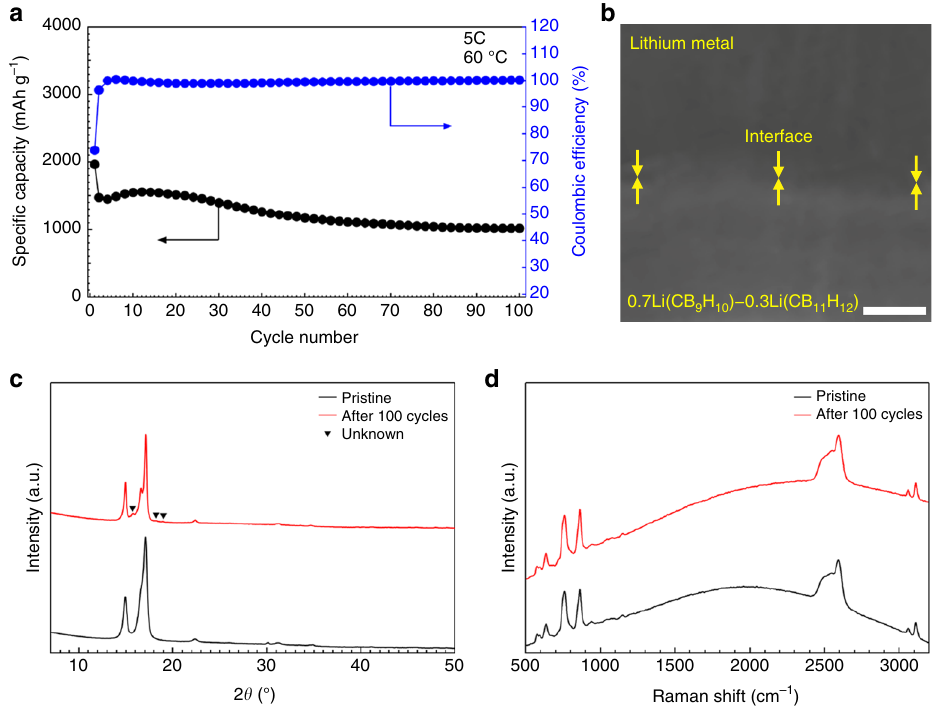
Fig. 6 Stability of 0.7Li(CB 9 H 10 ) – 0.3Li(CB 11 H 12 ) during prolonged cycling. a Cycling performance of discharge capacity and coulombic ef fi ciency for a discharging rate of 5 C and a charging rate of 1 C at 60 °C. b FE-SEM image of the 0.7Li(CB 9 H 10 ) – 0.3Li(CB 11 H 12 )/Li interface after 100 cycles. c XRD patterns and d Raman pro fi les of 0.7Li(CB 9 H 10 ) – 0.3Li(CB 11 H 12 ) before and after 100 cycles. A small amount of an unknown phase was detected in the